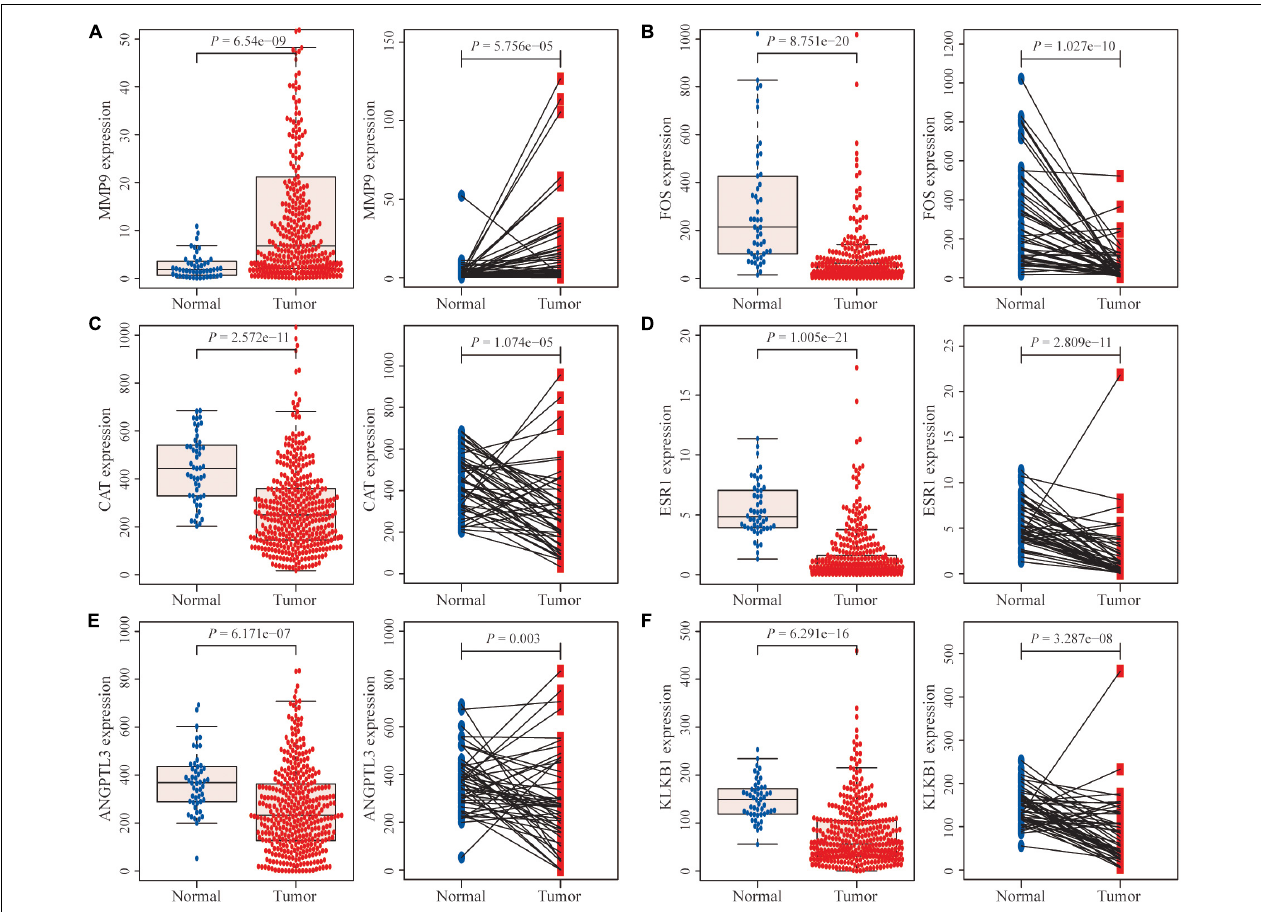
FIGURE 5 | Differential expression analysis of immune-related genes (IRGs). (A) The MMP9 gene was expressed at significantly higher levels in hepatocellular carcinoma (HCC) tissues than in normal HCC tissues and paired adjacent normal tissues. (B–F) The expression levels of the remaining five genes were significantly lower in tumor tissues than in normal tissues and paired adjacent normal